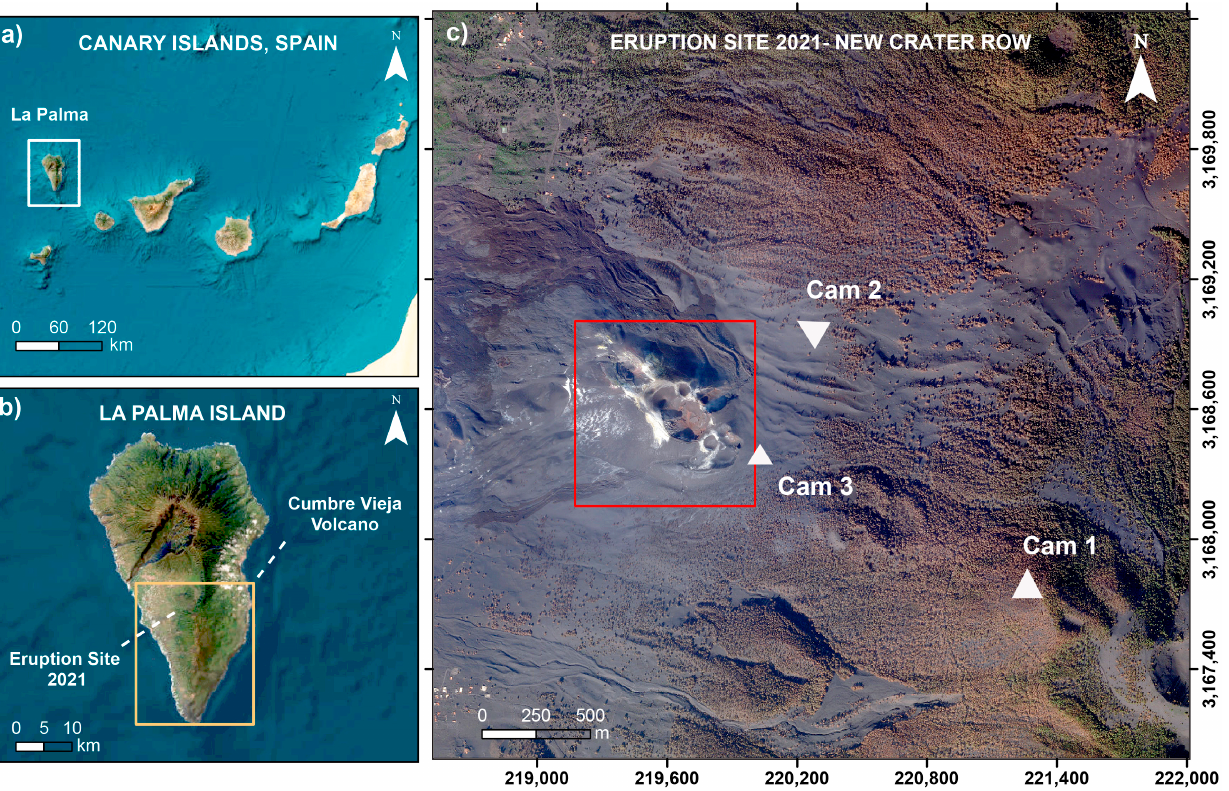
Figure 1. Study area. ( a ) The Canary Islands, highlighting La Palma Island inside the white box. ( b ) Close-up view of La Palma Island, highlighting the location of Cumbre Vieja Volcano inside the yellow box. ( c ) Close up of the 2021 eruptive cone showing a Skysat Image acquired on 31 December 2021 and indicating the location of the newly formed cone in 2021 in the red box. Here, it is possible to visualize the craters’ final surface structure and alignment. The white dots represent the location of three cameras, with their respective view angles, used to record the time-lapse images.